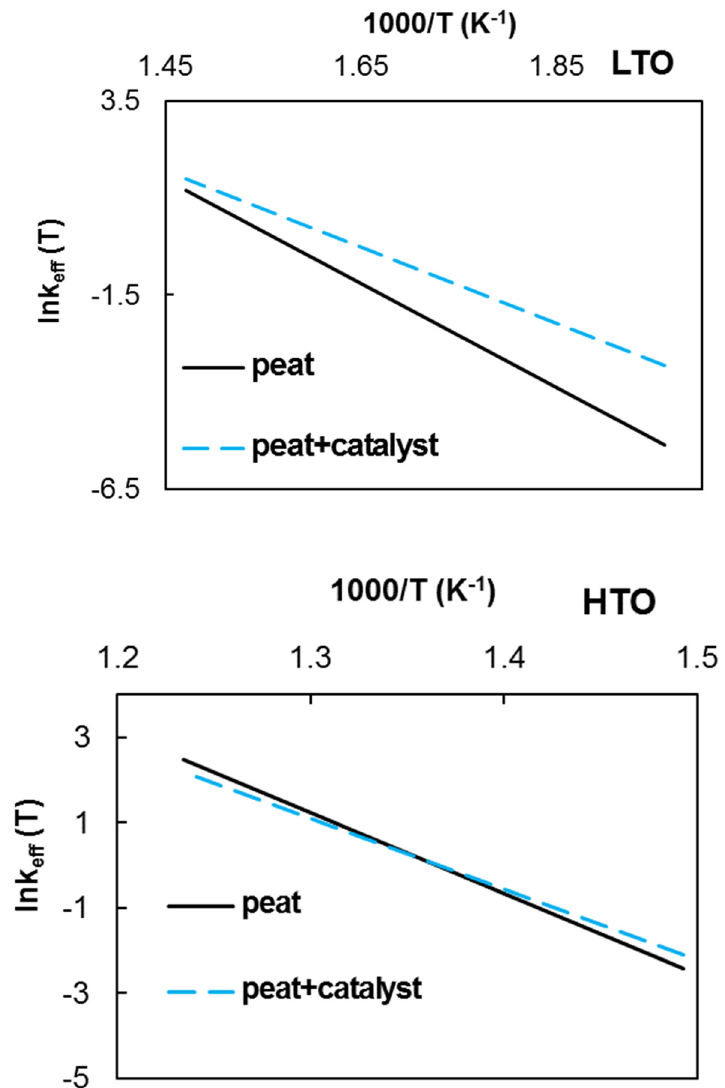
Figure 8. Variation of effective reaction rate constants with temperature for catalytic and non-catalytic peat oxidation.